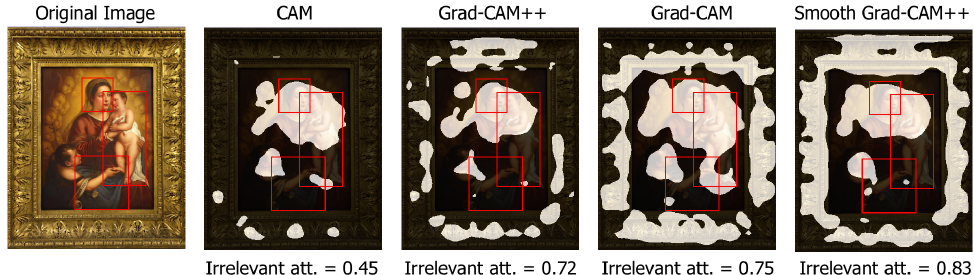
Figure 12. Different values of irrelevant attention produced by different class activation map algo- rithms (Smooth Grad-CAM++ with σ = 1 and s = 5) at threshold t = 0.1. Manually annotated symbol bounding boxes are reported.